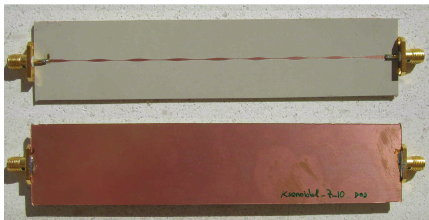
Figure 1: Photograph of the fabricated prototype in microstrip technology; top view of the metallic strip and bottom view of the unaltered ground plane.